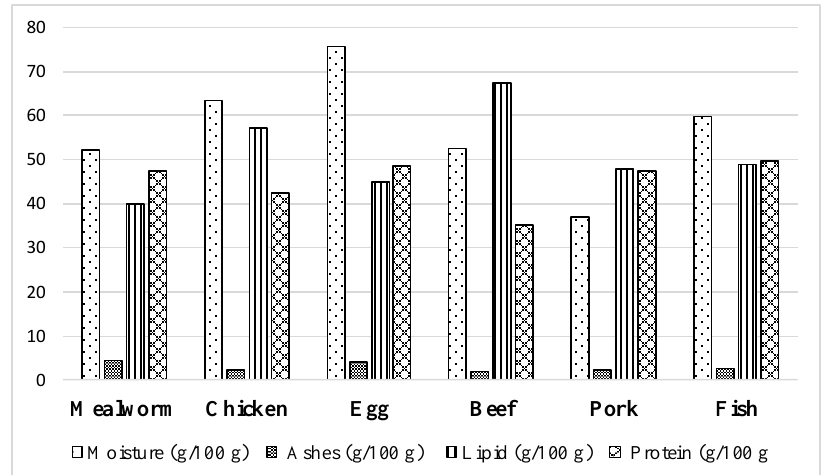
Figure 2. Comparison of the nutritional content of yellow mealworm larvae and conventional foods. Ashes, lipids and protein values based on dry weight. Source: Based on data from Alves et al.